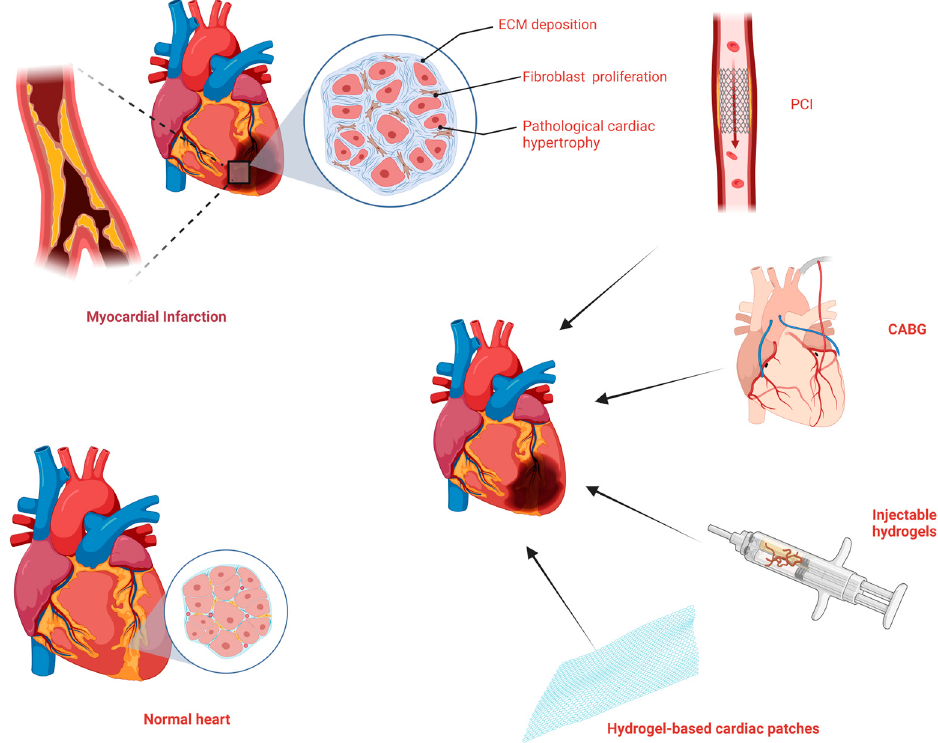
Figure 1. The pathophysiological changes and treatment of myocardial infarction. Created with Bi- oRender.com.